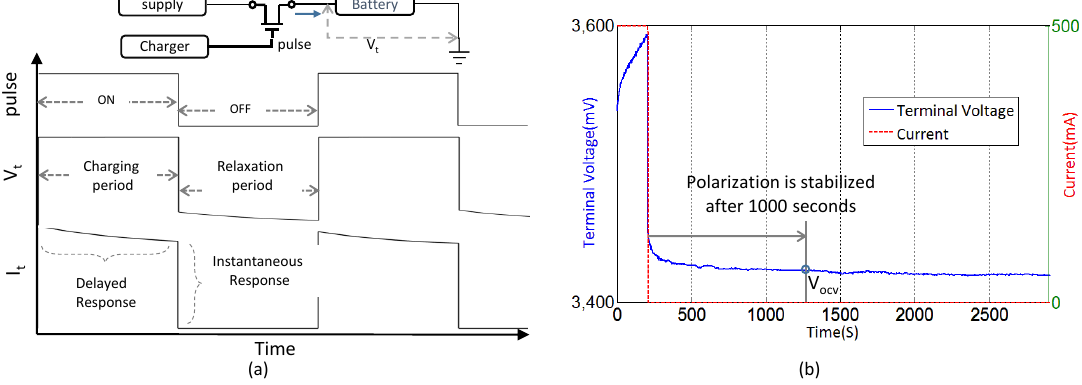
Figure 5. Relaxation after charging pulse. ( a ) battery charging current under 4.2 volts of charging pulse; ( b ) text result of diffusion after pulse on